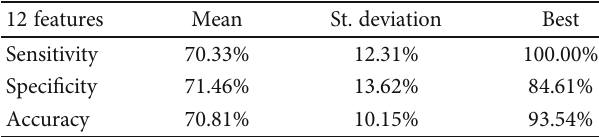
Table 10: Results for Logistic Regression with 12 features.